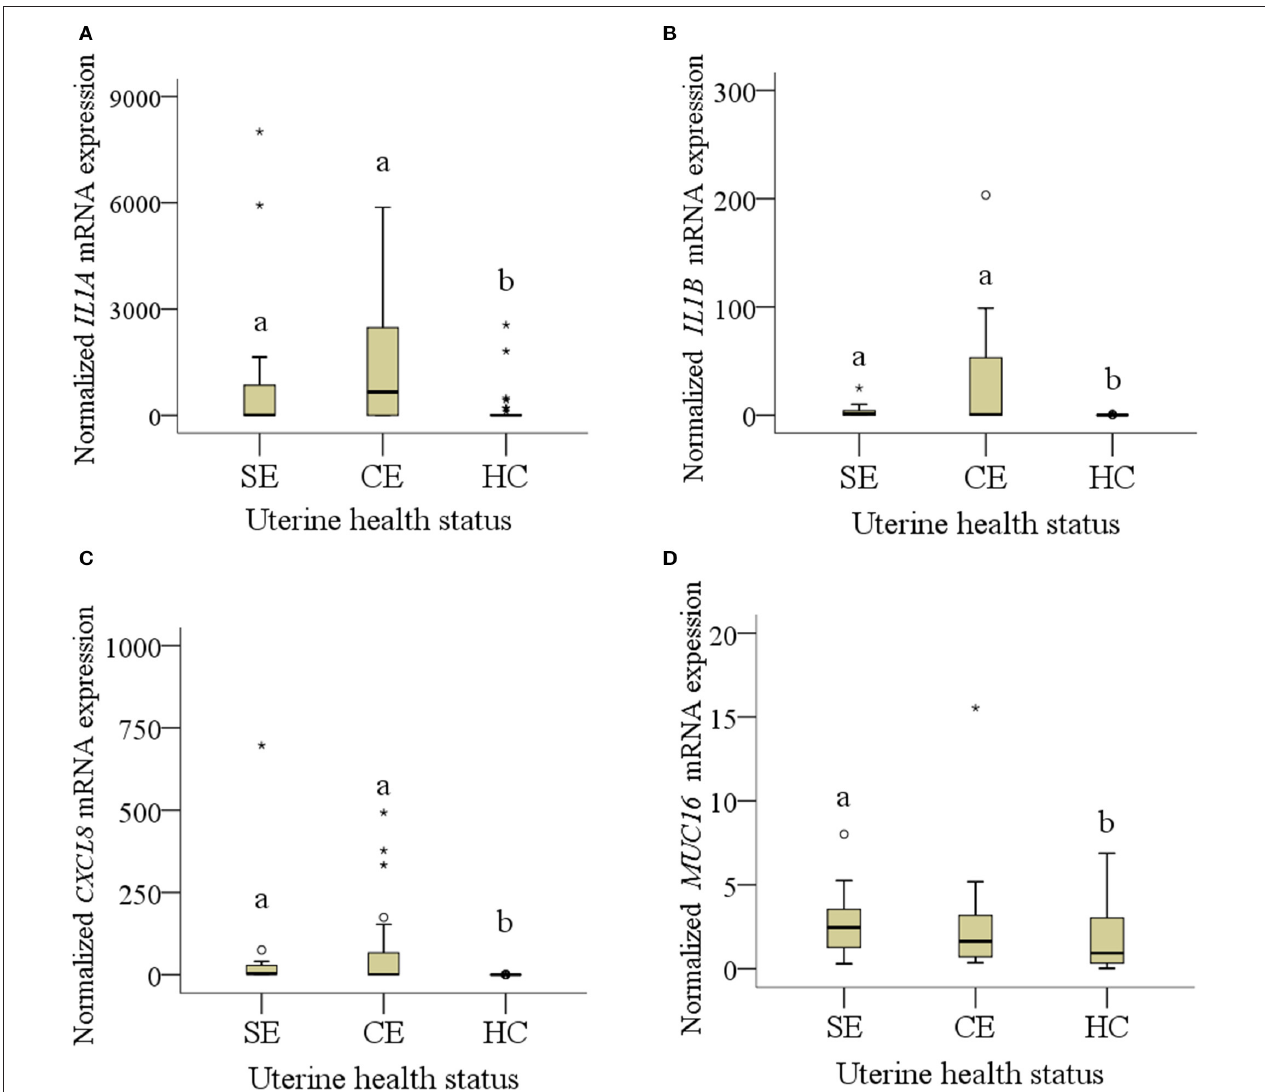
FIGURE 1 | (A–D) : mRNA expression of normalized (A) IL1A , (B) IL1B , (C) CXCL8 and (D) MUC16 collected from four cows (20 samples) with subclinical endometritis (SE), seven cows (31 samples*) with clinical endometritis (CE) and seven (35 samples) healthy cows (HE). In CE, four samples were missing because of failed cytobrush sampling. Only diagrams showing significant results of pro-inflammatory factors and mucins are presented. Different letters indicate significant differences between groups: a:b < 0.05. The circle mean outliers and asterisks mean extreme outliers